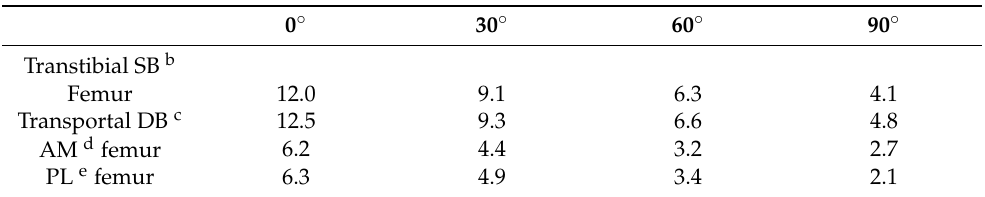
Table 2. Contact stress between femoral tunnel and graft during knee flexion combined with a 134 N anterior load. a